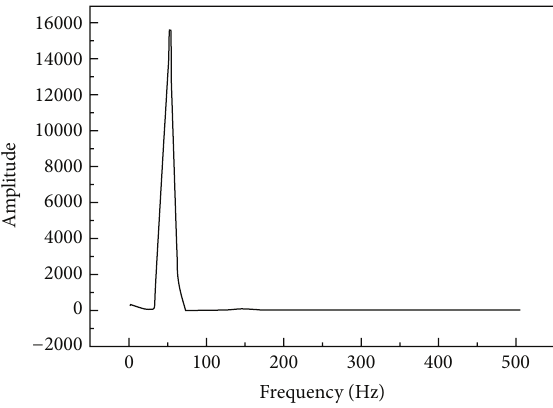
Figure 8: Spectrum analysis of the oscillating